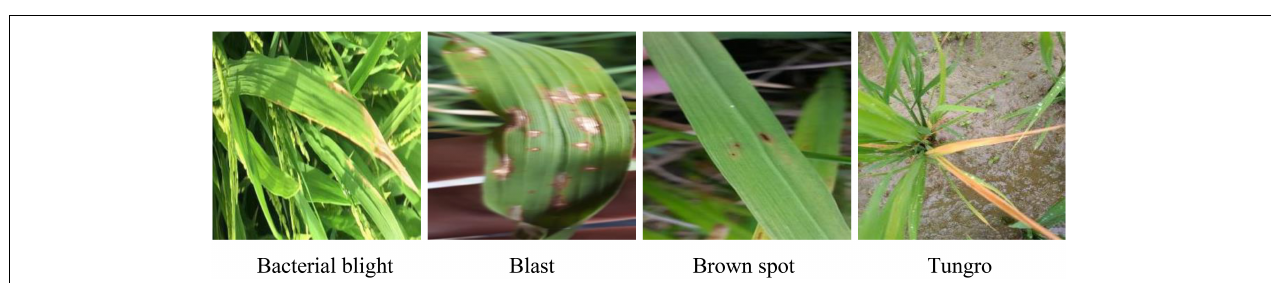
FIGURE 10 | Clustering results of the training set.